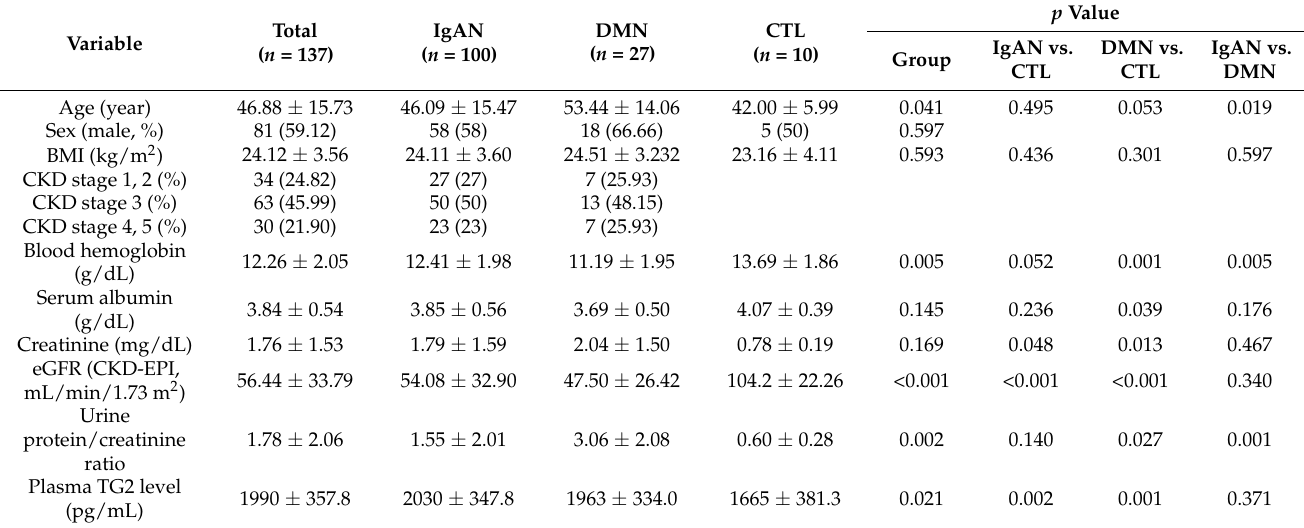
Values are means ± SD for continuous variables and n (%) for categorical variables. BMI: Body Mass Index.